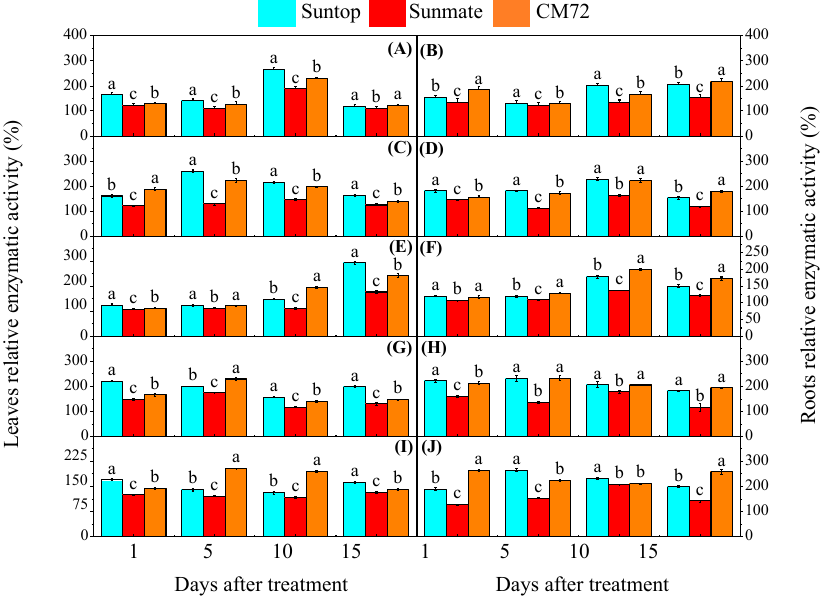
Figure 5. E ff ect of salinity stress on ( A , B ) superoxide dismutase (SOD) (U g − 1 FW); ( C , D ) peroxidase (POD) (OD 470 g − 1 min − 1 ); ( E , F ) ascorbate peroxidases (APX) (mmol g − 1 FW min − 1 ); ( G , H ) catalase (CAT) (mmol -1 FW min -1 ; ( I , J ) glutathione reductase (GR) (mmol g -1 FW min − 1 ) activities in leaves ( A , C , E , G , I ) and roots ( B , D , F , H , J ) of Suntop (Aqua), Sunmate (Red), and CM72 (Orange) 1, 5, 10, and 15 days after treatment with 100 mM NaCl. The data are expressed as a percentage of control activities. Di ff erent letters indicate significant di ff erences ( p ≤ 0.05) among the 3 cultivars within each sampling day. Error bars represent SE ( n =